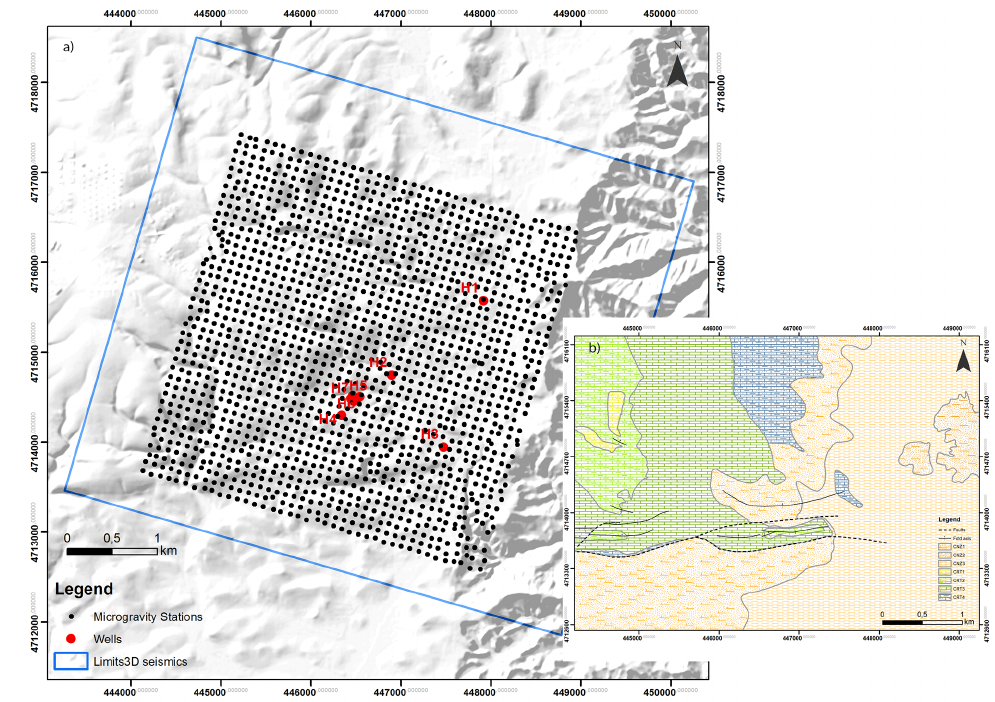
Figure 2. (a) Location of the gravimetric stations (dark dots), boundaries of the 3-D seismic experiment (blue line) and location of wells (red dots) and (b) geological setting of the Hontomín site and the stratigraphic succession (Alcalde et al.,